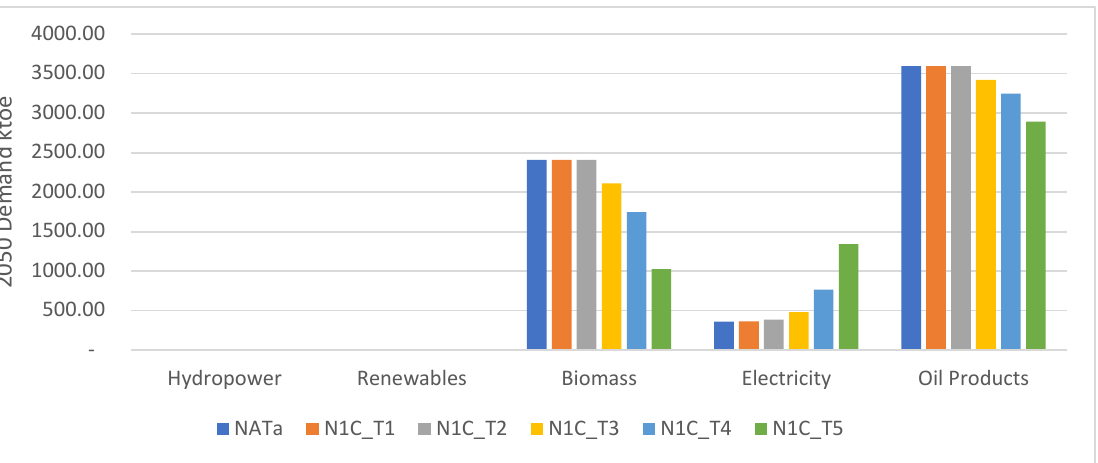
Figure 4. Energy demand by 2050 for scenarios based on NATa.